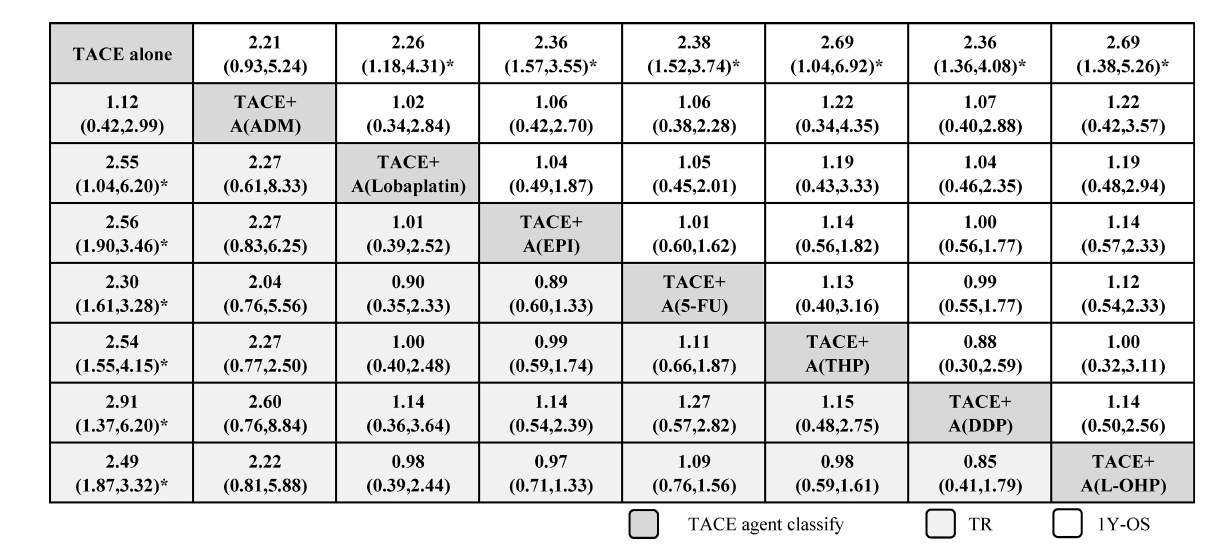
FIGURE 3 | League tables of ef fi cacy of TACE+apatinib versus TACE in treatment response and 1-year OS. Comparisons between treatment agents should be read from left to right, and the estimates in the cell are common between the column-de fi ning treatment and the row-de fi ning treatment. For ef fi cacy of treatment response and 1-year OS, an OR more than 1 favors the column-de fi ning treatment. To obtain ORs for comparisons in the opposing direction, reciprocals should be taken. 5-FU, 5- fl uorouracil; A, apatinib; ADM, doxorubicin; DDP, cisplatin; EPI, epirubicin; L-OHP, oxaliplatin; RTACE, transarterial chemoembolization; THP, pirarubicin. *Signi fi cant results are in